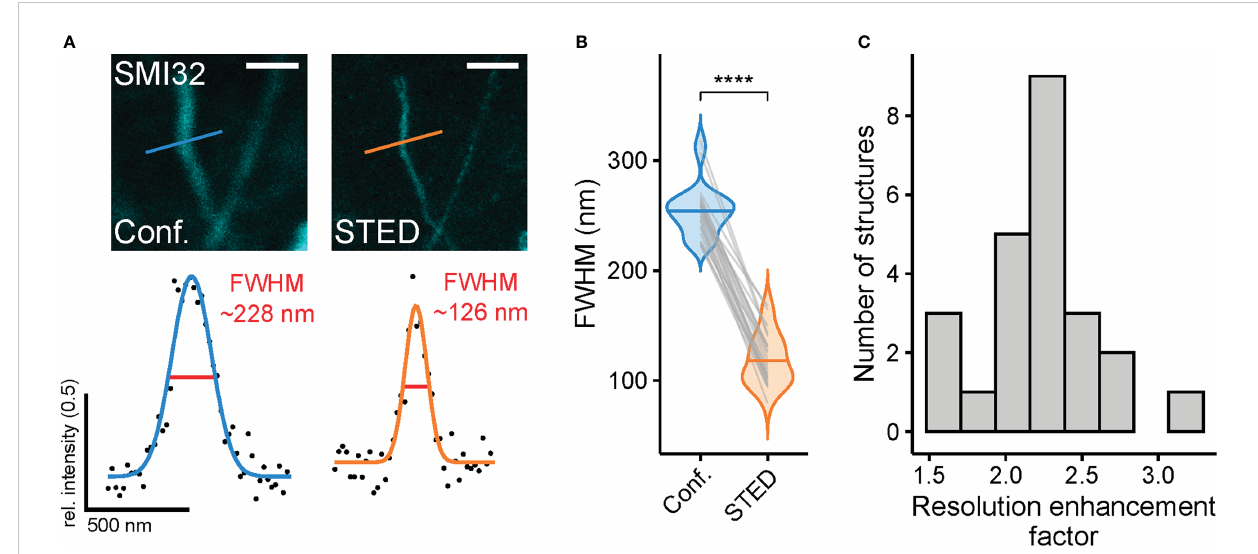
FIGURE 4 Super-resolution STED imaging of SMI32-positive retinal ganglion cell dendrites in the inner retina reveals spatial resolution enhancement (A) Example structures (top, dendrite of a SMI32-positive RGC) for resolution estimation and with FWHMs for dendritic structure for confocal (blue) and STED (orange) (bottom). FWHM intensity pro fi les taken at the indicated position in example confocal and STED images. (B) Comparison of FWHMs in confocal (blue) and STED (orange) images (p< 0.0001 = ****, Wilcoxon signed-rank test, n = 1 animal; n = 24 fi lamentous structures from 3 images, horizontal bars indicate means, grey lines connect corresponding values). (C) Histogram of resolution enhancement factor quanti fi ed as ratio between the FWMHs of confocal and STED images (n = 24). For A, the excitation wavelength was 635 nm, and the dye was ATTO647N. Scale bar: 1 µm in